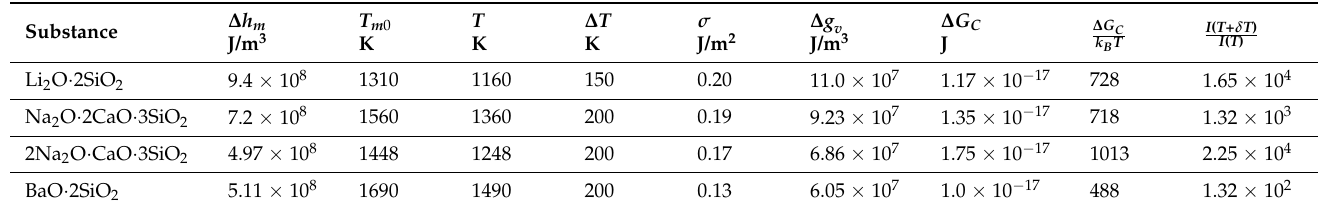
in silicate glasses at δ T = − 1 I ( T )